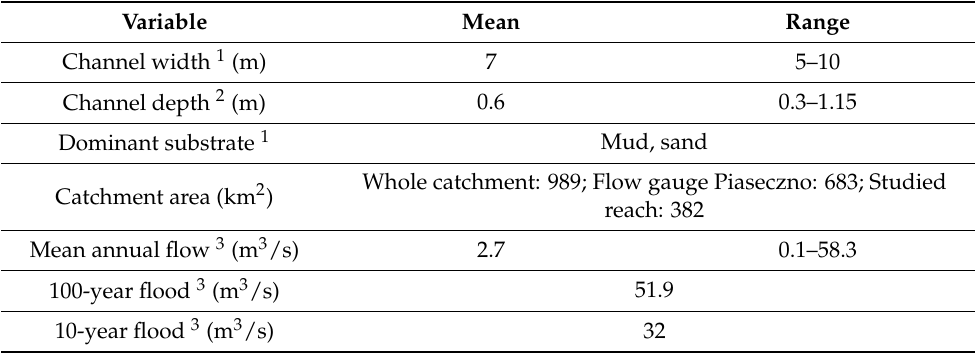
Table 1. Selected abiotic characteristics of the Jeziorka